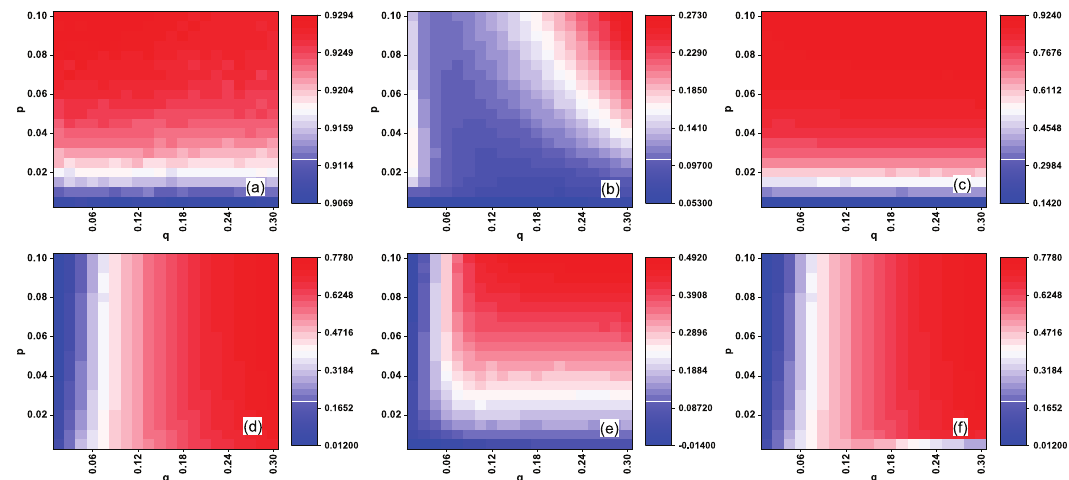
Fig 4. (Color online) The effectiveness of the EigenRank algorithm under random rating attack for the Netflix data set: (a) the AUC values AUC e ; (b-c) Δ AUC e , the comparison of AUC e between EigenRank algorithm and IBeta method (b), Vote ( L ); (e-f) Δ R ( L ), the comparison of recall between EigenRank algorithm and IBeta Aggregation method (c); (d) the recall R c c method (e), Vote Aggregation method (f). The parameters q and p denote the ratio and the activity of spammers, respectively and L = q | U |. q ranges from 0.015 to 0.3 in increments of 0.015 and p ranges from 0.005 to 0.1 in increments of 0.005. One observes that both the AUC and R ( L ) of the EigenRank algorithm exceed those of the IBeta method and Vote Aggregation method for different e c ( p , q ).